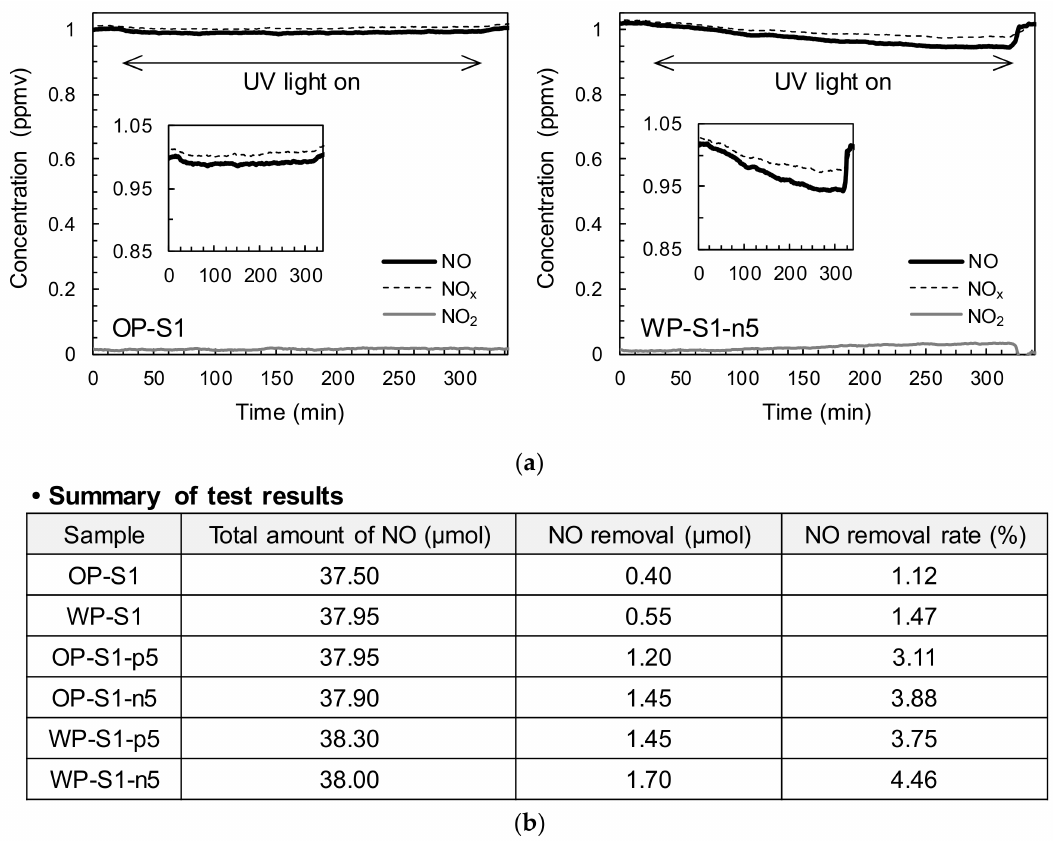
Figure 6. Summary of NO removal rates: ( a ) typical NO x concentrations and time behaviors (OP-S1 and WP-S1-n5), ( b ) summary of test